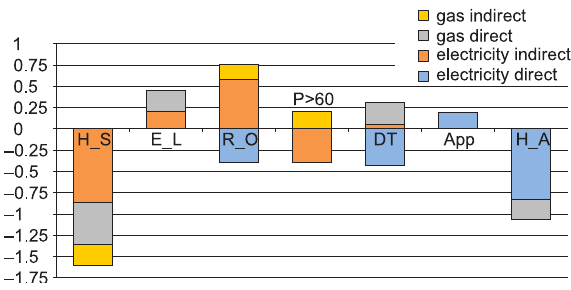
fig. 13. Direct and indirect effect of variables on